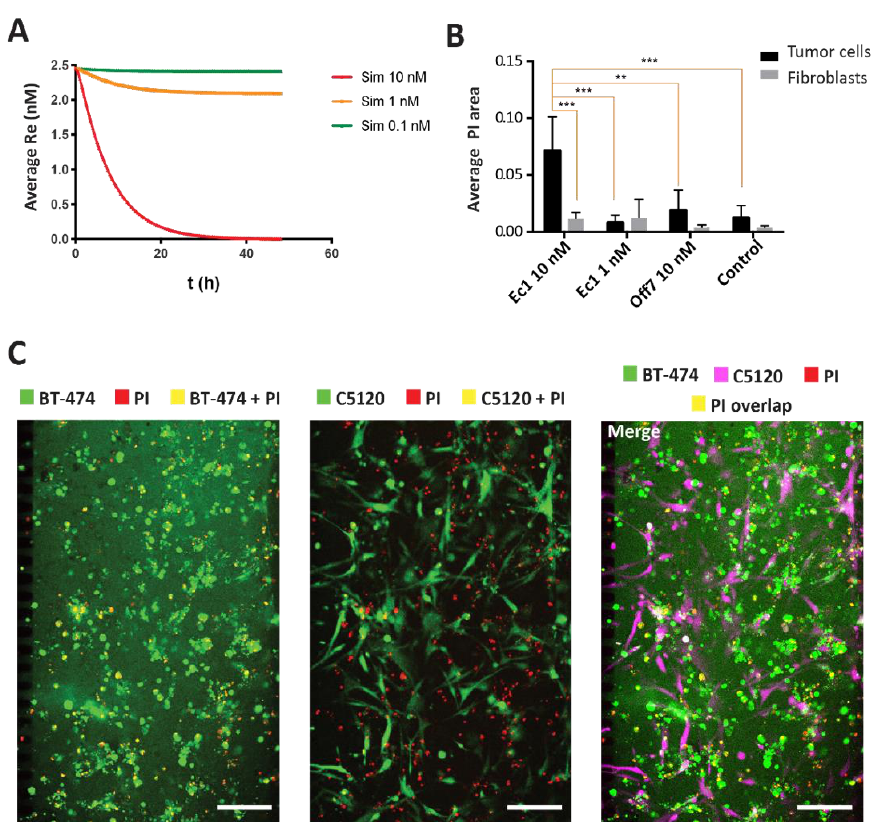
Figure 5. Simulation and experimental verification of Ec1-ETA-mediated tumor cell killing. ( A ) Simulations for Ec1-ETA at concentrations of 0.1 nM, 1 nM, and 10 nM in the model. Toxic effects are approximated in the model through omitting receptor recycling. Overall receptor levels (Re) on the y -axis thus serve as a proxy for the overall cell viability. Receptor levels/cell viability is depicted as a function of time integrated over the entire volume of the tumor compartment in the microfluidic device. Re—receptor level reflecting overall viability. ( B ) Quantification of the overlapping area between the PI channel and the cell (tumor or fibroblasts) channels. Error bars reflect SEM. ** means p < 0.001, *** means p < 0.0001 based on a two-way ANOVA; n = 3 ( C ) Microscopy images after 48 h of incubation with 10 nM Ec1-ETA in a co-culture of BT-474 and C5120 cells. The overlapping area between the tumor cells or fibroblasts in green and propidium iodide (PI) in red yields a yellow pseudo color. The scale bars represent 200 µm.